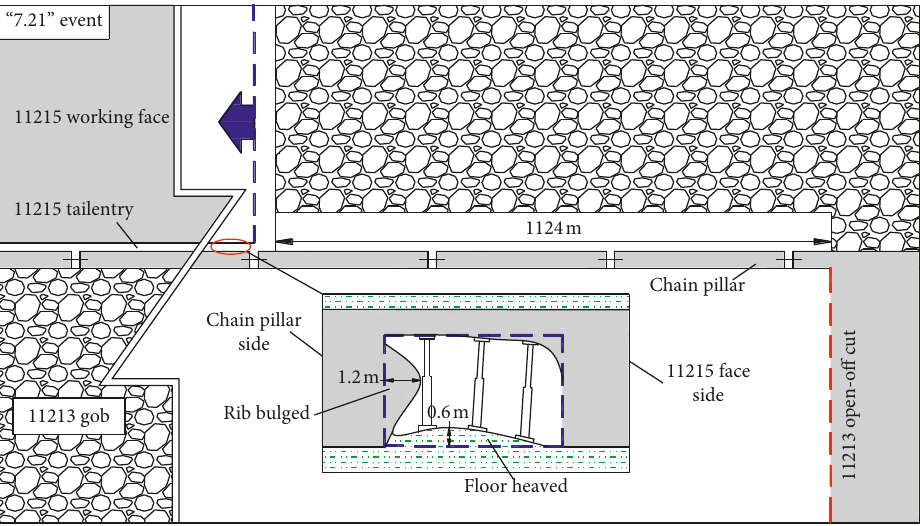
Figure 7: Sketch of the “7.21” event.